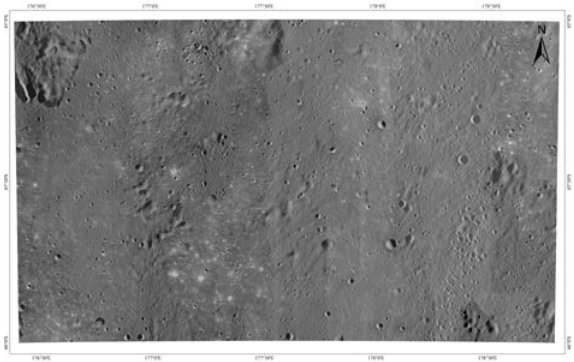
Figure 9. The resultant seamless DOM mosaic of CE-4 landing